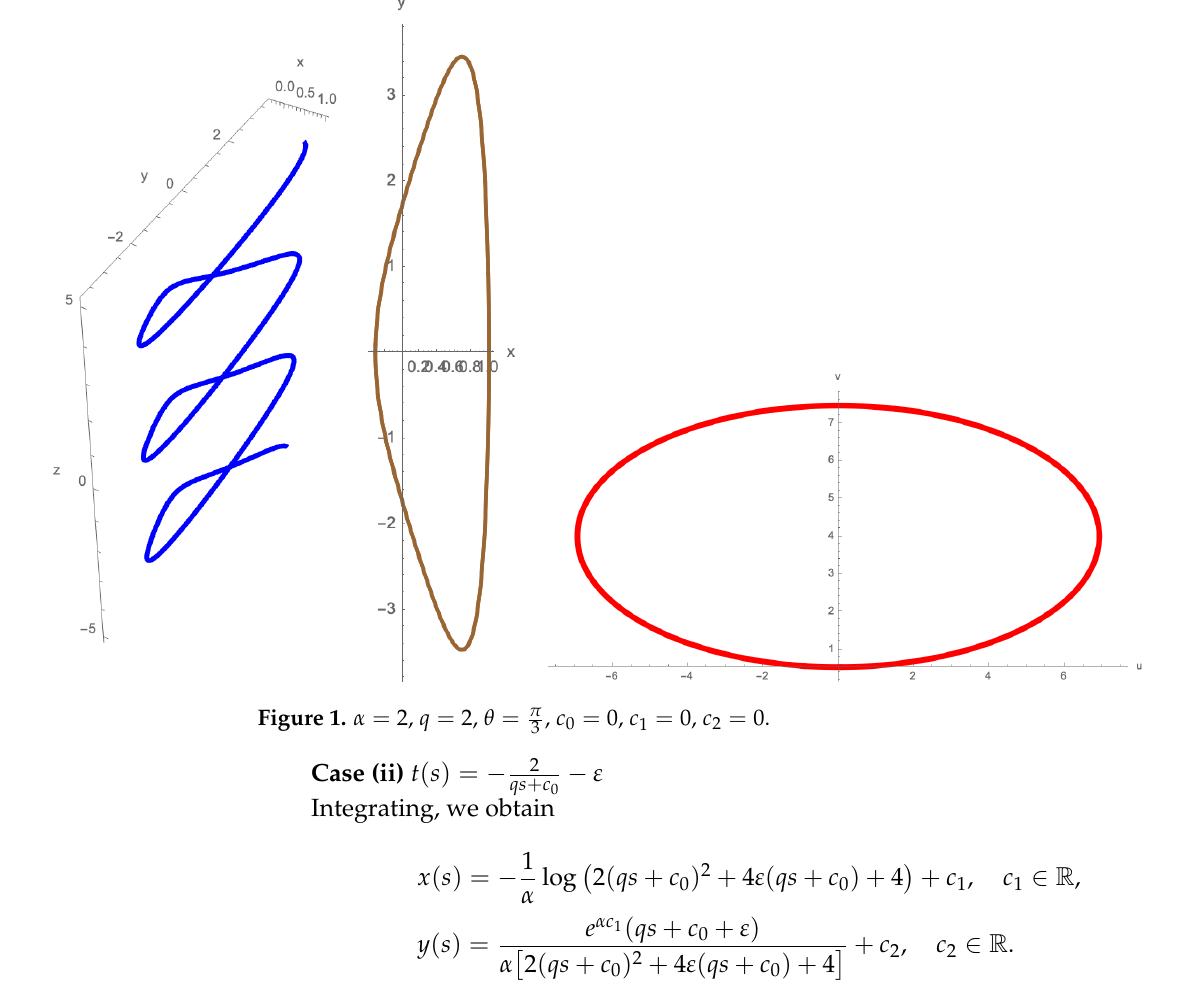
Figure 1. α = 2, q = 2, θ = π